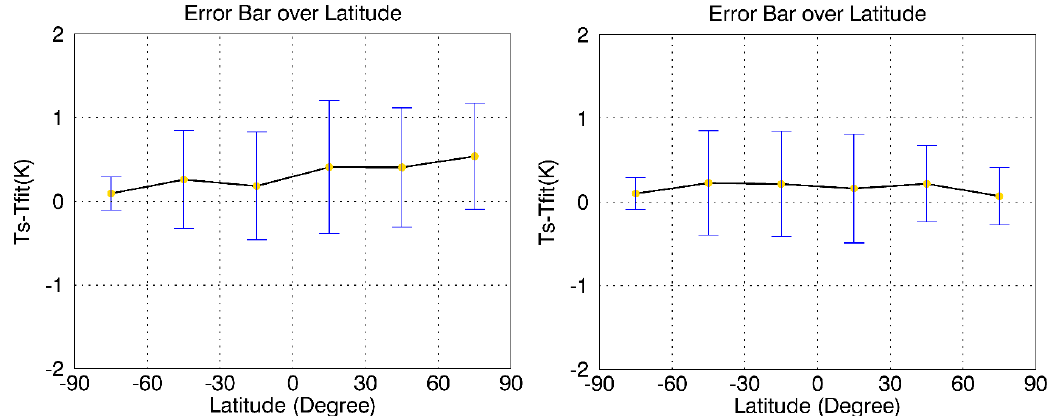
Figure 6. Fitting performance over latitude for daytime (left) and nighttime (right).